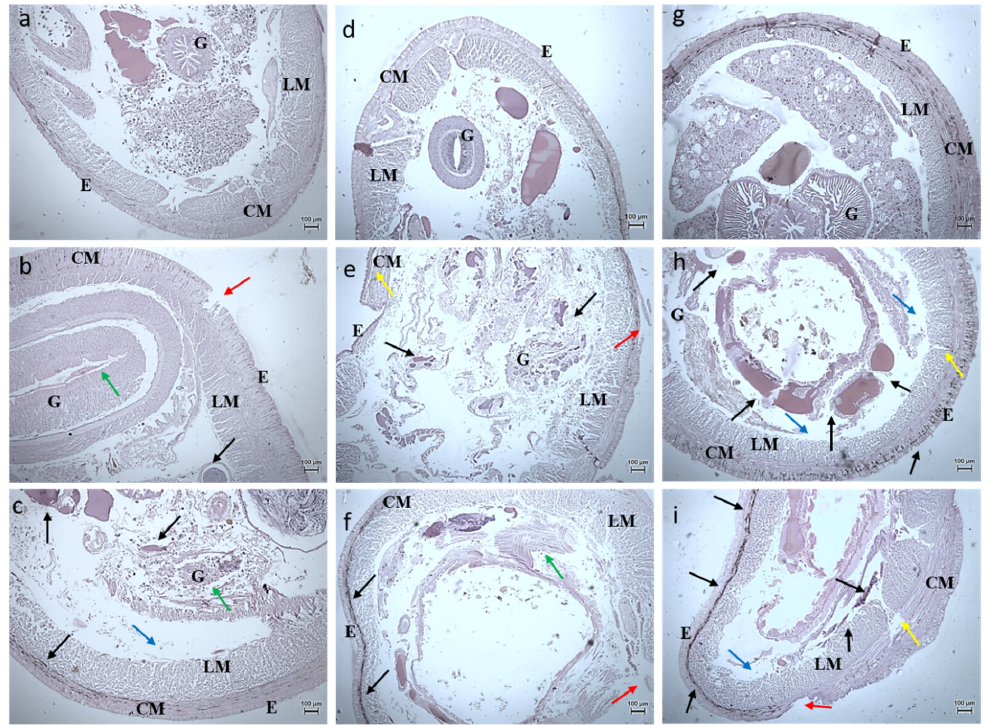
Figure 11. Histology images of foregut region of earthworm— Eudrilus eugeniae (10X Magnification) ( a ) 10th day control, ( b ) exposed to 10 µ g at 10th day, ( c ) exposed to 20 µ g at 10th day; ( d ) 20th day con- trol, ( e ) exposed to 10 µ g at 20th day, ( f ) exposed to 20 µ g at 20th day; ( g ) 30th day control, ( h ) exposed to 10 µ g at 30th day, ( i ) exposed to 20 µ g at 30th day. G—Gut, E—Epidermis, LM—Longitudinal Muscle, CM—Circular Muscle. Black arrow denotes lipofuscin, red arrow denotes erosion of epider- mis, blue arrow denotes interstitial space, yellow arrow denotes fibrosis of CM, green denotes arrow disruption of